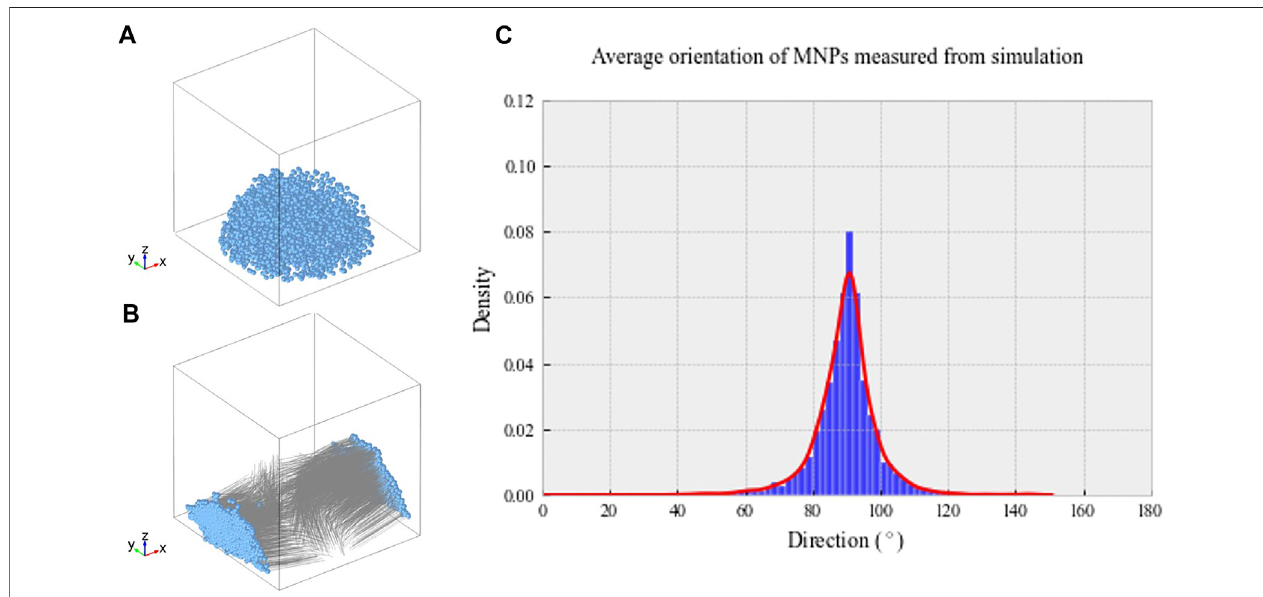
FIGURE 1 | (A) Randomized MNP position within a model culture well plate at t = 0 s. (B) Final MNP positions at t = 0.1 s, with the magnetic fi eld applied in the X direction.TheMNPpositionsareindicatedinblue,withgraylinesdemonstratingmotionoverthesimulatedtimeframe. (C) AveragedensityofMNPsbetween0and180 ° withinourmagneticdevicesimulatedthroughcomputationalmodeling.GreatestMNPdensitywasrecordedat90.33 ° alignedwiththemagnetic fi eld,asindicatedbythe highest peak on the